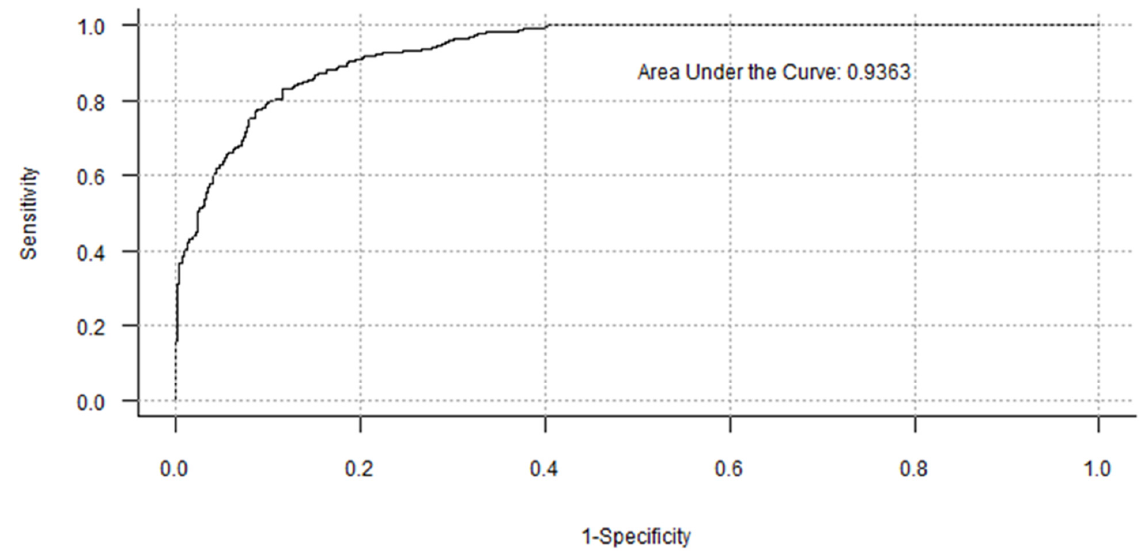
Figure 7. Receiver Operating Characteristic (ROC) curve illustrating the area under the curve (AUC) for the random forest classifier.